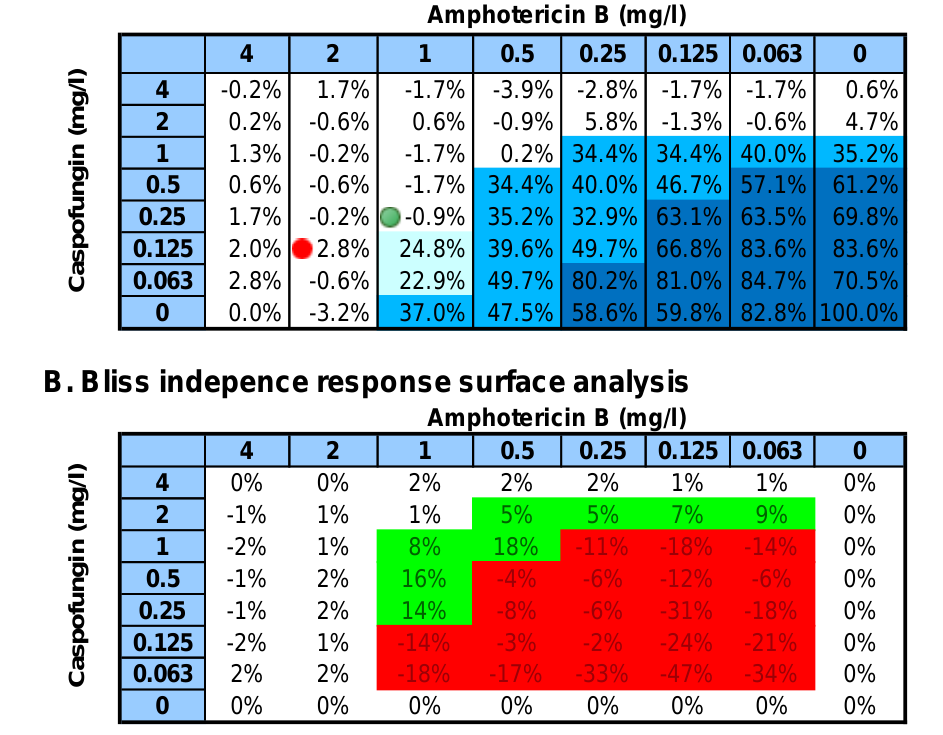
Figure 1. Schematic representation of Fractional inhibitory concentration (FIC) index analysis ( A ) and Bliss independence response surface analysis ( B ) of the caspofungin+amphotericin B combination against the C. albicans #92 strain tested in center 2. ( A ) The numbers in the cells are percentages of growth. ∑ FICmin (green dot) was 0.625, and ∑ FICmax (red dot) was 1.06. ( B ). The numbers in the cells are percentages of Bliss interactions. Green-colored cells represent synergistic interactions, whereas red-colored cells represent antagonistic interactions. Note that FIC index analysis captures pharmacodynamic interaction at concentrations near MIC, whereas Bliss interaction analysis captures interactions at the entire range of concentrations. Interactions at lower concentrations could be captured with FIC index using MIC-1, MIC-2, and MIC-3 corresponding to 25%, 50%, and 75% growth, shown by different shades of blue.